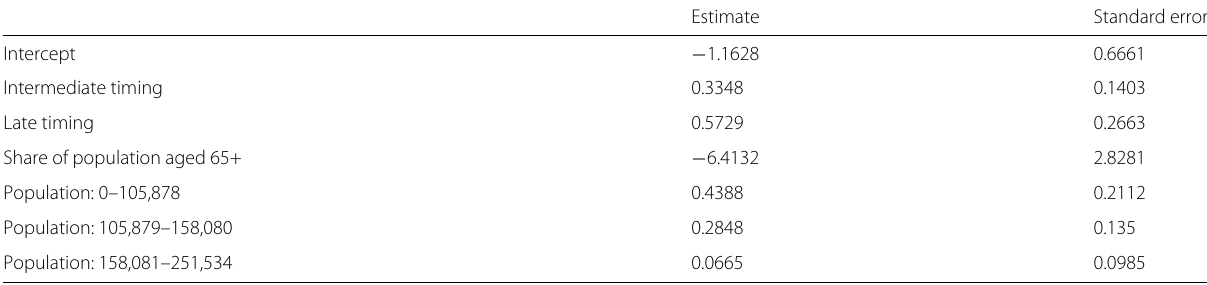
Table 4 OLS estimates for Germany 28 days after the start of the county-specific epidemic with fatalities per 10,000 inhabitants as outcome variable